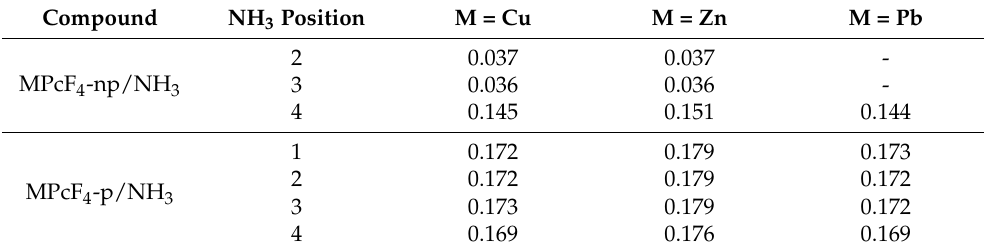
Table 4. The binding energies (in eV) of the NH 3 molecule with MPcF 4 (M = Cu, Zn, Pb) phthalocyanines. Compound